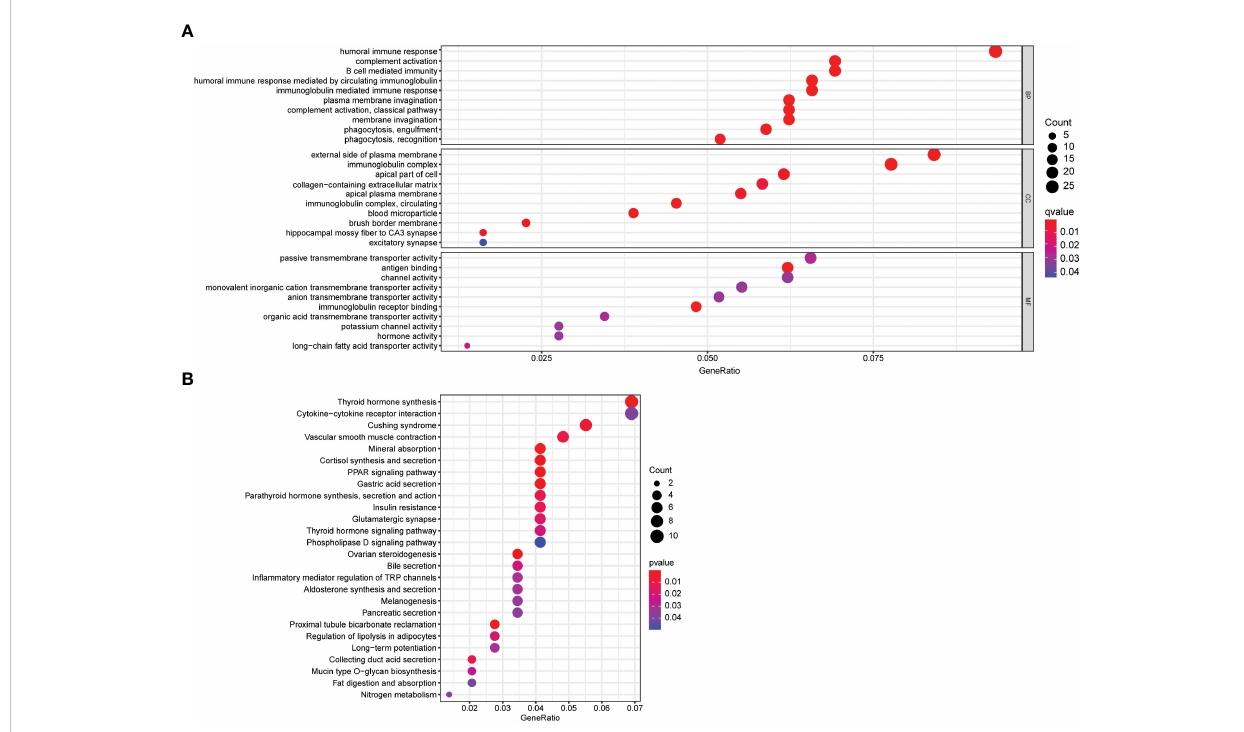
FIGURE 6 Functional enrichment analysis of DEGs. (A) Top 10 biological process (BP) terms, cellular components terms (CC), molecular functions (MF) terms. (B) Top 26 Kyoto Encyclopedia of Genes and Genomes (KEGG)